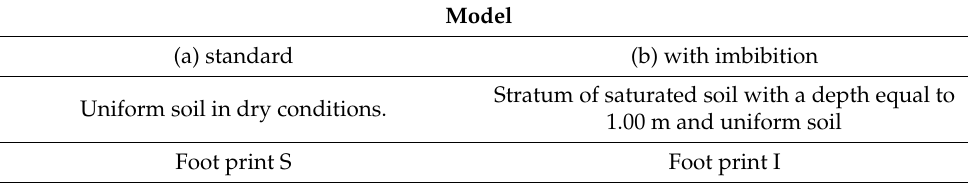
Table 3. Implemented